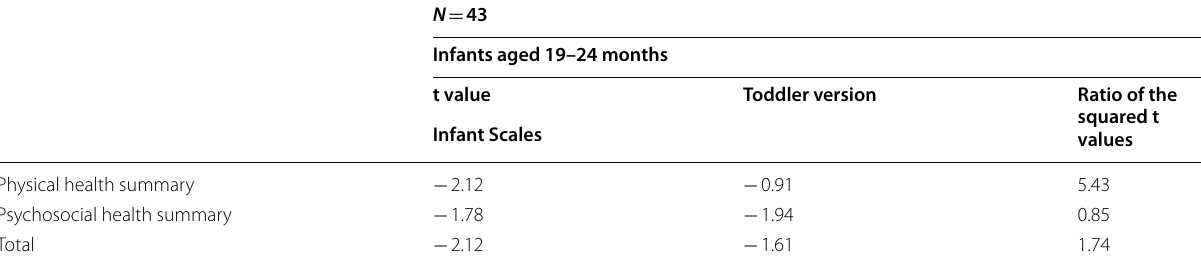
Table 9 Relative validity of the Japanese version of the PedsQL Infant